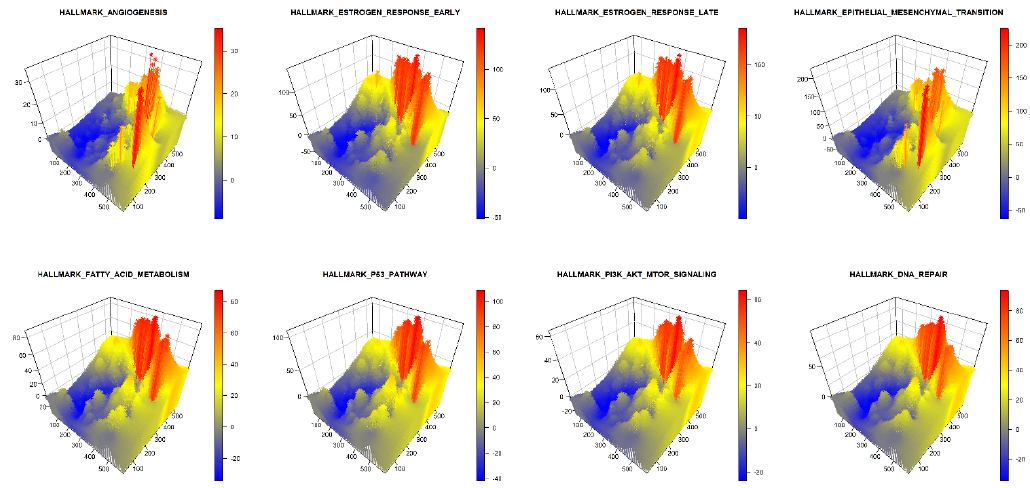
Figure 4. A 3D snapshot of the spatial enrichment z scores for different hallmark gene sets of cancer. The x and y dimensions define the tissue space while the z dimension represents the spatial enrichment z score ( SEZ ) at a given point. The name of each hallmark gene set appears over its plot.